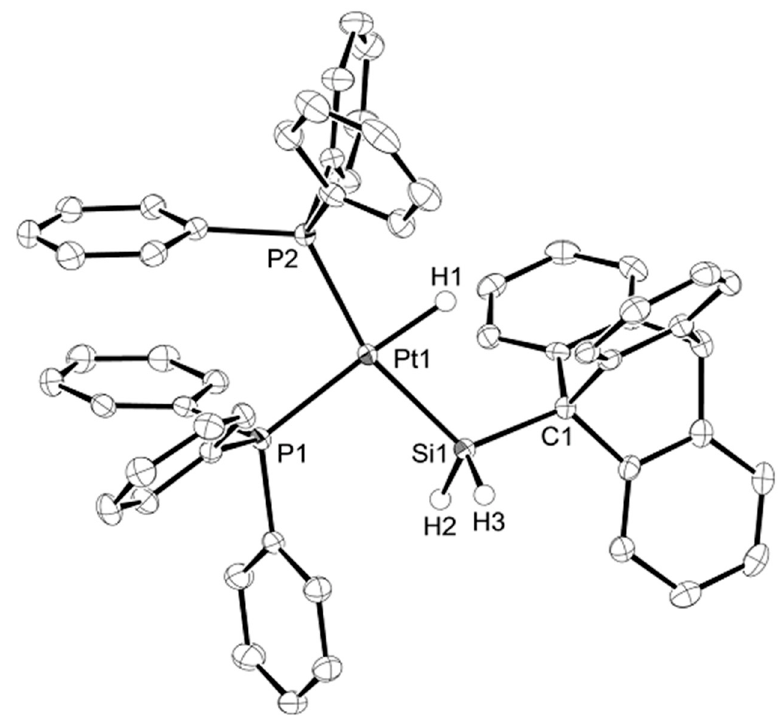
Figure 1. ORTEP of [ cis -PtH(SiH 2 Trip)(PPh 3 ) 2 ] 2 (50% thermal ellipsoids, a solvation toluene molecule, and hydrogen atoms, except H1, H2, and H3 were omitted for clarity). Selected bond lengths (Å) and